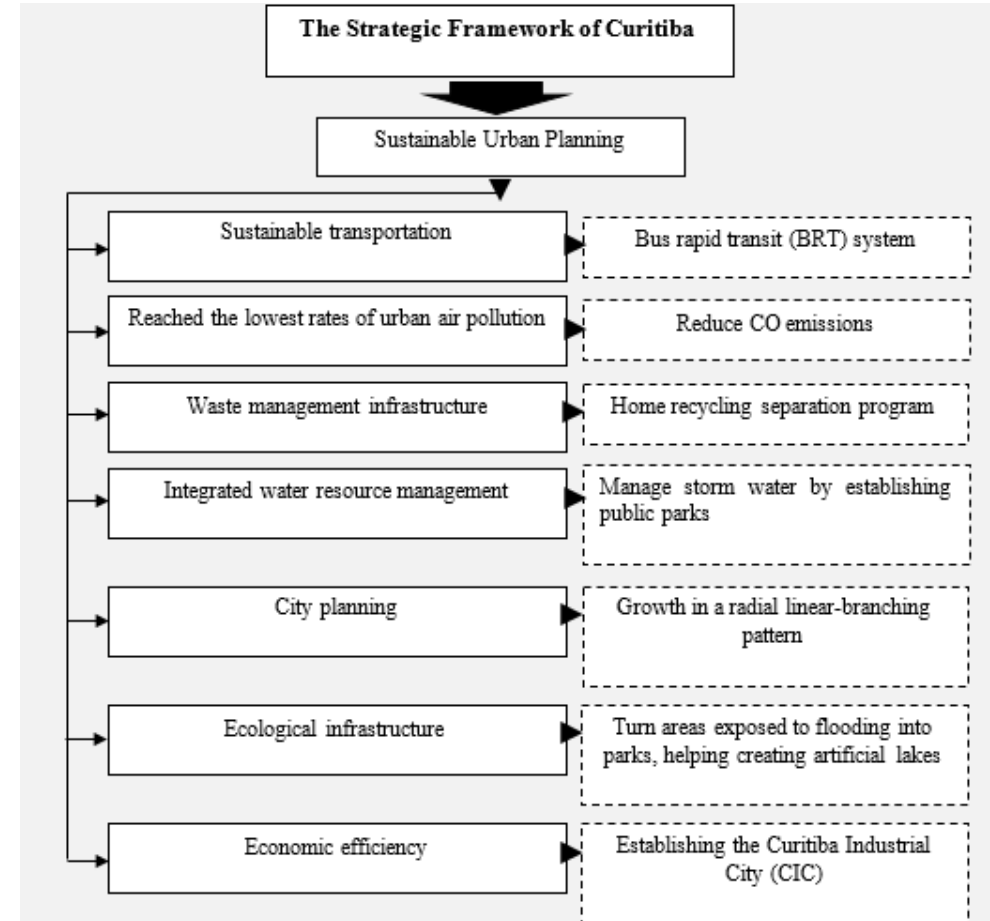
Figure 3. The strategic framework of Curitiba for a green economy Reference: The Author